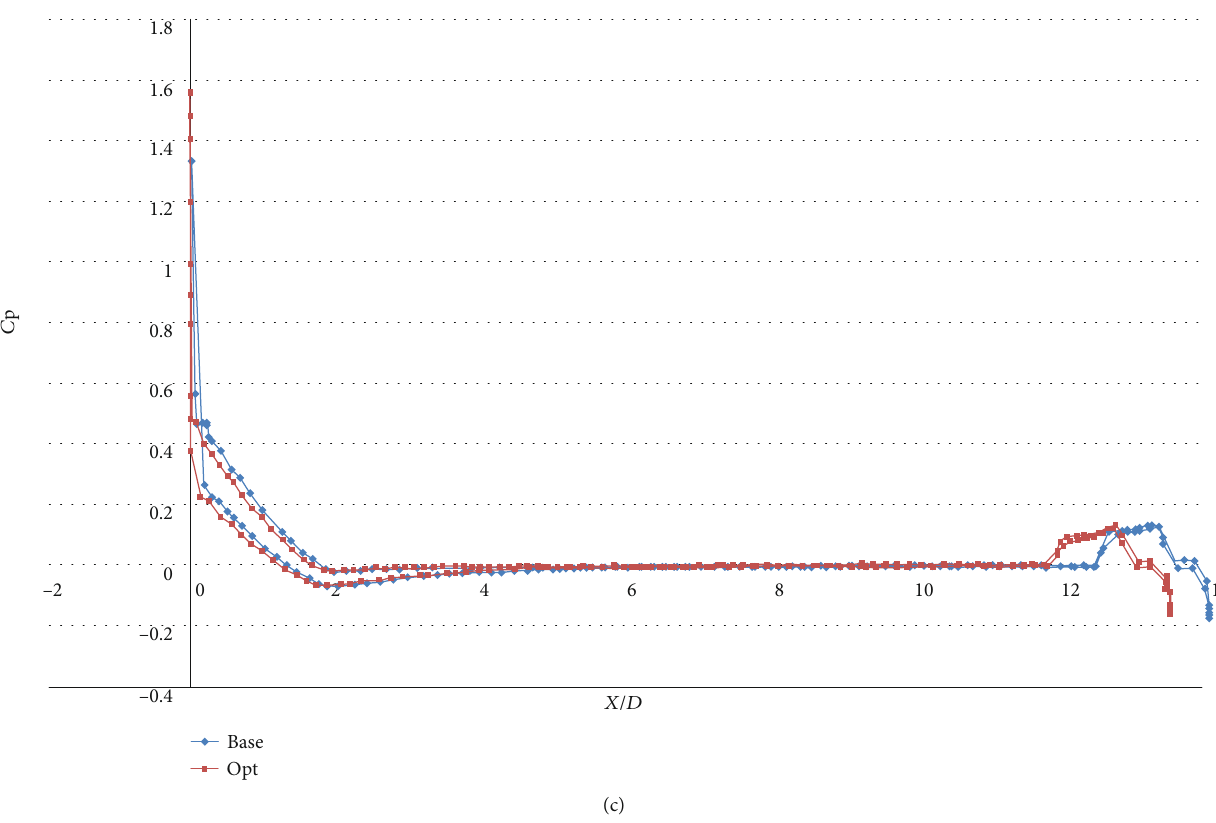
Figure 16: Pressure coe ffi cient distribution for the base and optimum missile body at 4 ° AoA: (a) Mach 1.4, (b) Mach 2, and (c) Mach